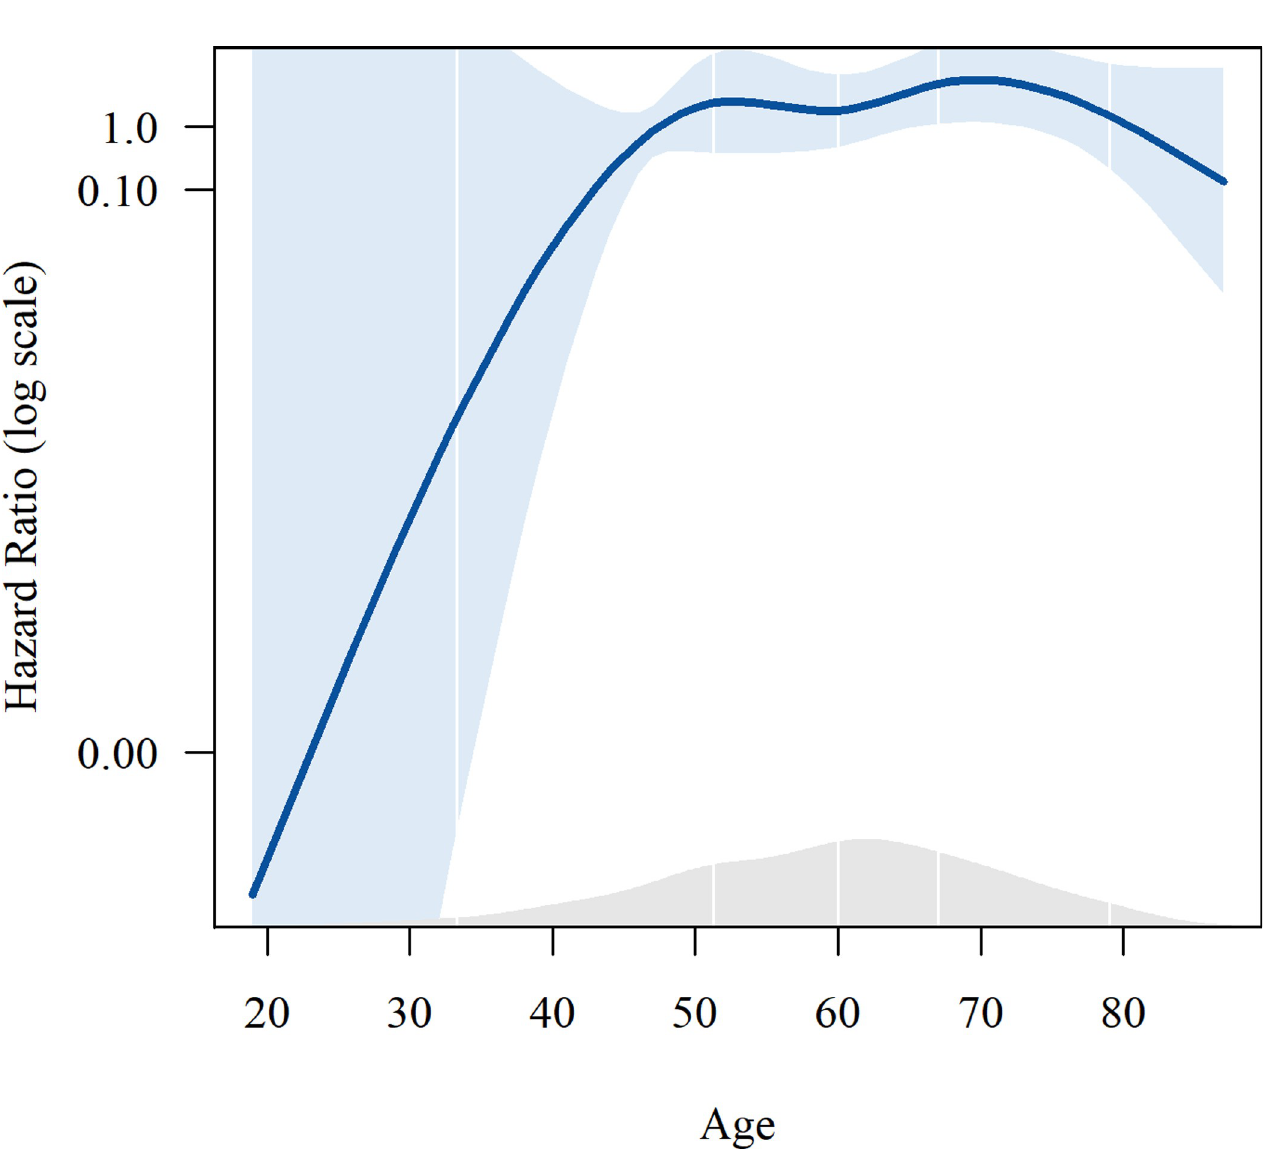
Fig 2. Plots of splines for age in the best performing multivariate model predicting progression in leave-one-out analysis.